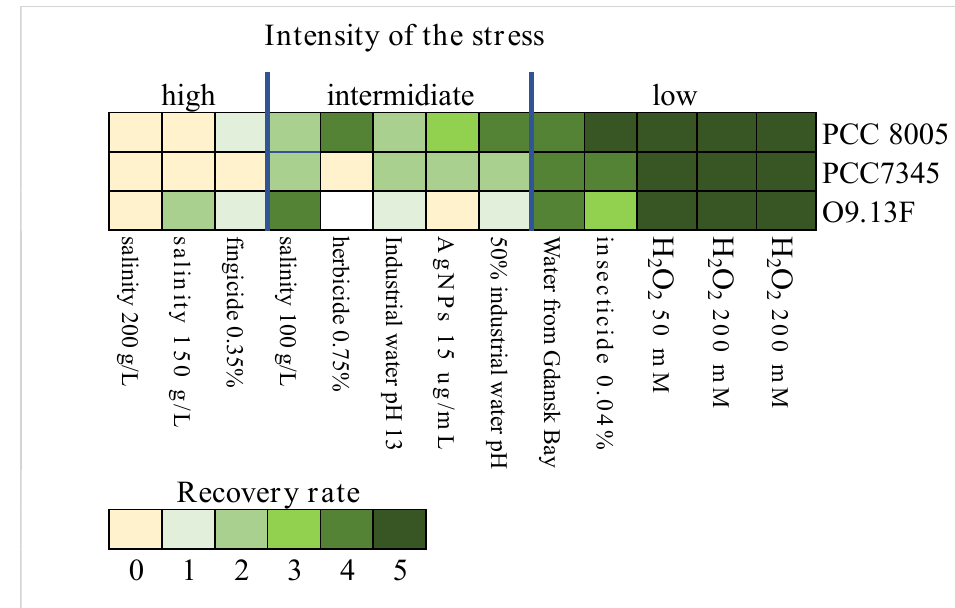
Figure 5. The heatmap presents the recovery rates of eight tested Arthrospira strains, O9.13F, PCC 7345 and PCC 8005 cultivated in stress conditions. Above the heatmap, three levels of the stress severity (low, intermediate, high) are grouped according to the overall similarity of the different strains’ responses. The colour scale given in the heatmap key corresponds to the recovery rate. The survivability of the biomass was assessed based on the condition, duration of the lag phase and visible increase in the number of viable filaments and recorded by the following system: 0—degradation of the filaments, 1—whole, nonfragmented filaments present, no growth observed, 2—growth observed after two weeks of a lag phase, 3—very weak growth recorded after one week of a lag phase, 4—stable growth after a short lag phase, 5—very abundant growth without a lag